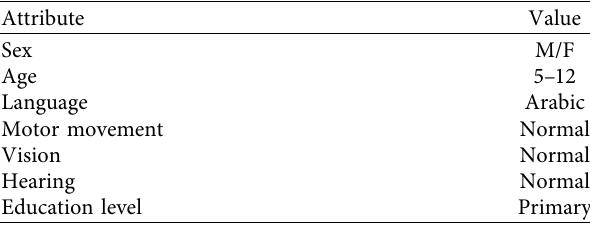
Table 2: Attributes of students with communication difficulties.